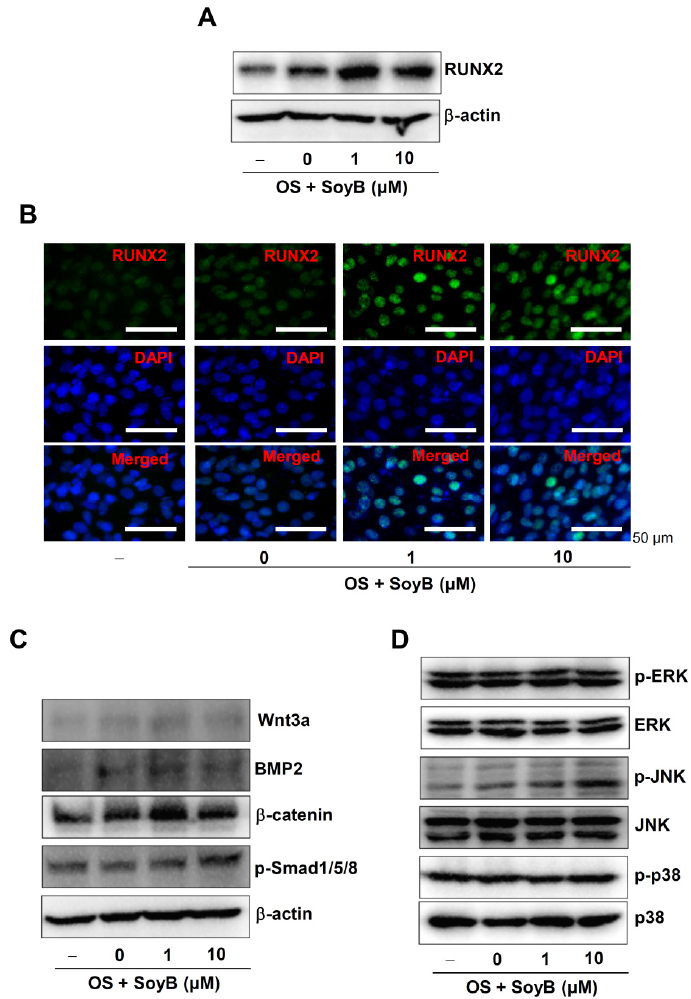
Figure 3. Osteogenic effects of SoyB on the RUNX2 expression and upstream molecules. ( A , B ) Total RUNX2 expression levels were assessed using Western blot analysis ( A ), and nuclear RUNX2 ex- pression and localization were determined using RUNX2 (green) and DAPI (blue) staining and observed under a confocal microscope ( B ). Scale bar: 50 µ m. ( C , D ) Equal amounts were probed using antibodies against Wnt3a, BMP2, β -catenin, phospho-Smad1/5/8 (p-Smad1/5/8), β -actin ( C ), phospho-ERK1/2 (p-ERK1/2), ERK1/2, phospho-JNK (p-JNK), JNK, phospho-p38 (p-p38), and p38 ( D ). Data represent the results of three independent